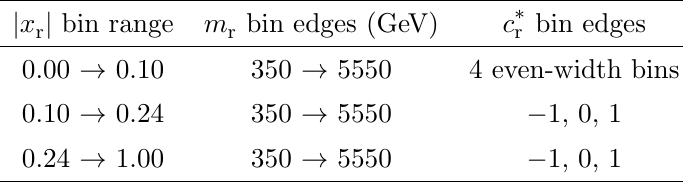
Table 4 . Template binning in the type-1 e+jets signal regions (each template has 8 total bins).